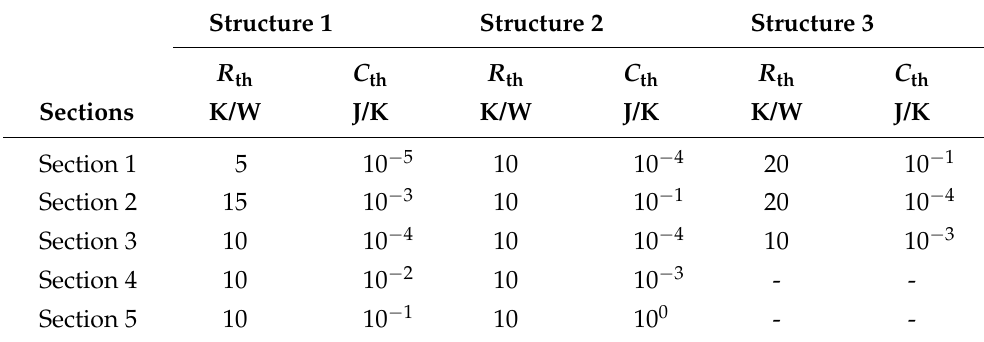
Figure 2. Relative deviation in thermal resistance for structure 1 at 10 6 points for ζ ∈ [ − 20,10 ] . Table 1. For the purpose of comparison, three reference structures are defined as a chain of uniform RC transmission lines, where each section has a thermal resistance and